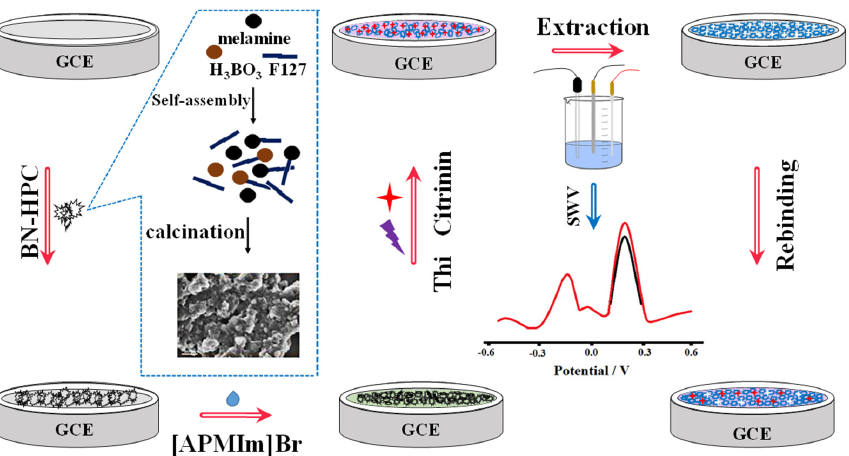
Figure 7. ( A ) Diagrammatic representation of a dual-mode immunosensor that mimics oxidase utilizing Co/NCNT: ( B ) (a) The Co/NCNT synthesis method; the low-resolution (b) and (c and d) high-resolution TEM pictures, as well as the matching electron diffraction images (illustration of d), EDS; ( C ) (a) colorimetric photos, (b) fluorescence spectroscopy, and (c) ochratoxin A (OTA) calibration plot with various concentrations (a–j: 0, 0.001, 0.005, 0.01, 0.05, 0.1, 0.5, 1, 5, 10 μ g/L). Adapted with permission from the article [70]. 2022, Elsevier.